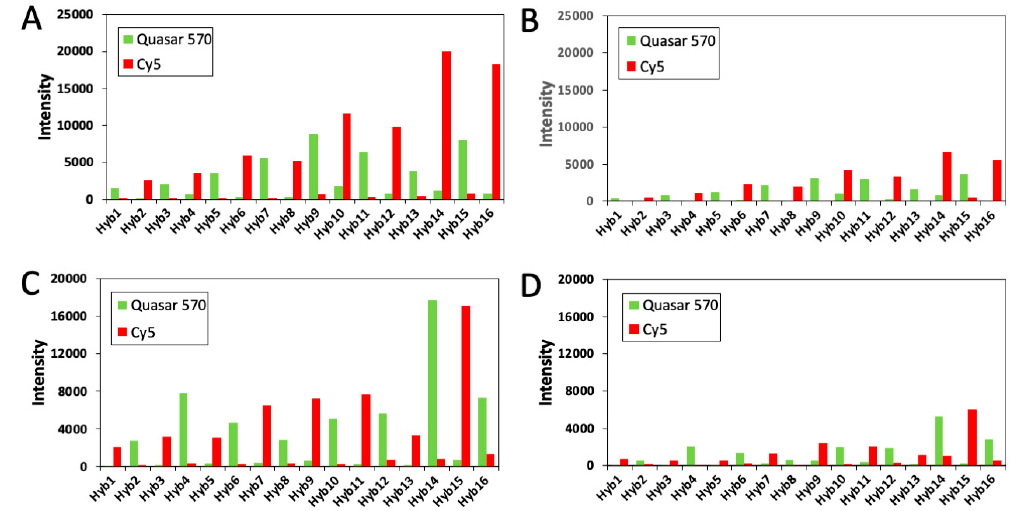
Figure 8. ( A ) Signal intensity profiles of a GAPDH transcript with strong intensities in Figure 6. ( B ) Signal intensity profiles of a GAPDH transcript with weak intensities in Figure 6. ( C ) Signal intensity profiles of a Ki67 transcript with strong intensities in Figure 6. ( D ) Signal intensity profiles of a Ki67 transcript with weak intensities in Figure 6. The signal intensities in the Quasar 570 and Cy5 channels are shown in green and red, respectively.